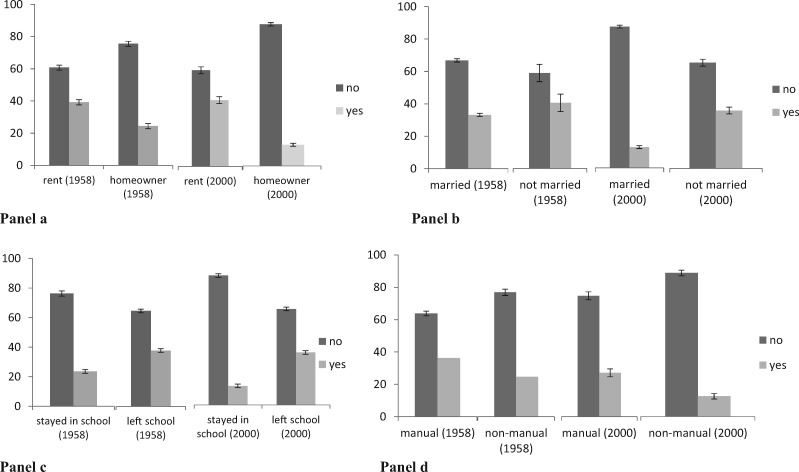
Percentage of those who smoked or did not smoke in pregnancy by family adversity for each cohort. Panel a: percentage smoking in pregnancy by housing tenure by cohort. Panel b: percentage smoking in pregnancy by marital status at birth of child by cohort. Panel c: percentage smoking in pregnancy by education status by cohort. Panel d: percentage smoking in pregnancy by occupational status by cohort. Home ownership includes owned outright or with mortgage.